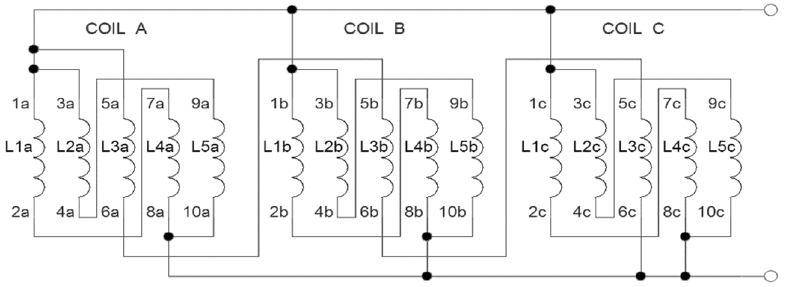
Figure 7. Final harvesting device, and scheme of the array.